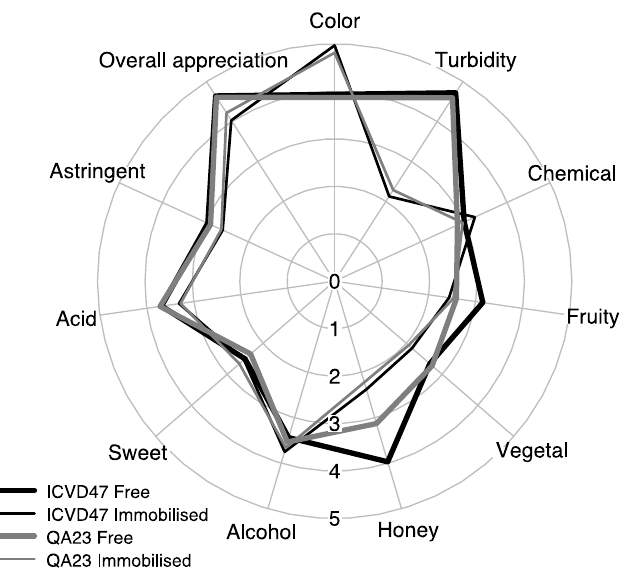
Figure 2. Radar plot of the mean aroma descriptors obtained for the meads produced using the two strains, QA23 and ICV D47, with free or immobilized cells.